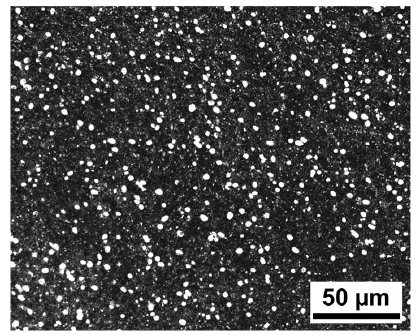
Figure 1. The microstructure of TC27.